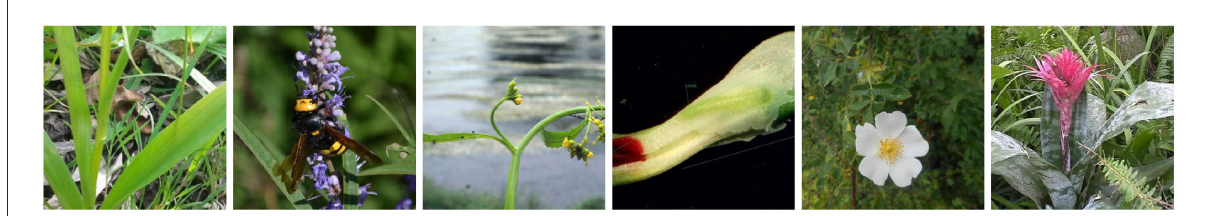
FIGURE1 “In the wild” photograph samples—PlantCLEF datasets. Images by soyoban, Liliane Roubaudi, Hugo Santacreu, Sarah Dechamps, Richard Gautier, Heinz Gass, Alain Bigou, Jean-Michel Launay, and Jose Luis